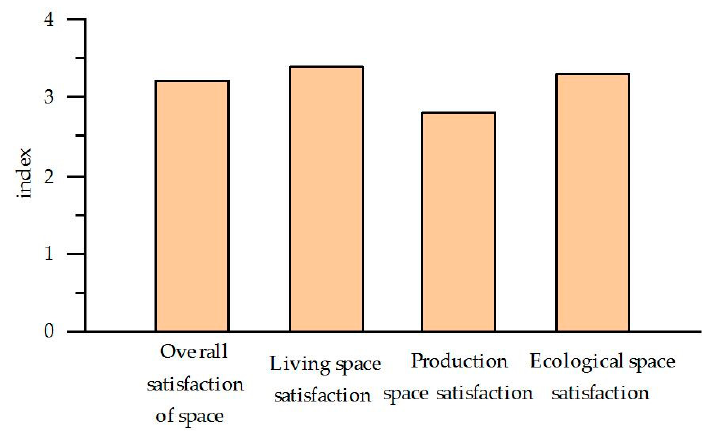
Figure 3. Overall evaluation of satisfaction with Ecological–Living–Productive spaces.